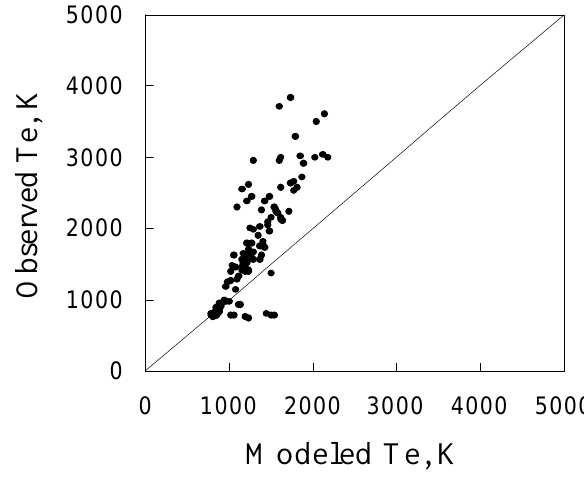
Fig. 5. Scatter plot of observed electron temperature at ∼ 500km versus electron temperature predicted by IRI for Fig.5. Scatter plot of observed electron temperature at ~500km versus electron temperature predicted by IRI for winter.